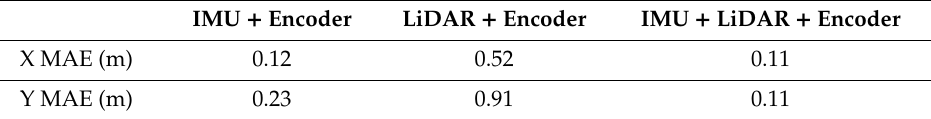
Table 3. Field experiment results of the autonomous robot’s location